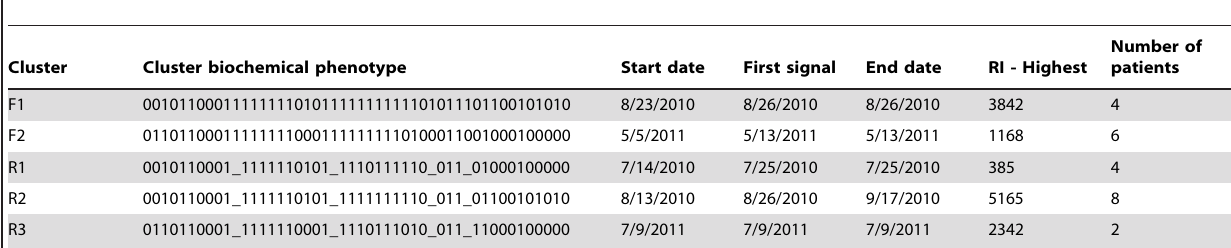
Table 6. Comparison of the WHONET-SaTScan cluster findings when utilizing full (F) and reduced (R) biochemical phenotypes of Klebsiella pneumoniae